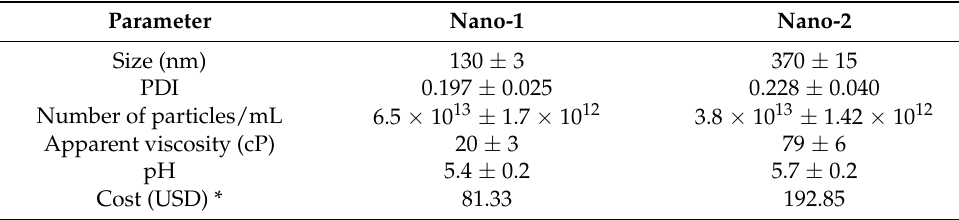
Table 5. Physicochemical characteristics of Nano-1 and optimized